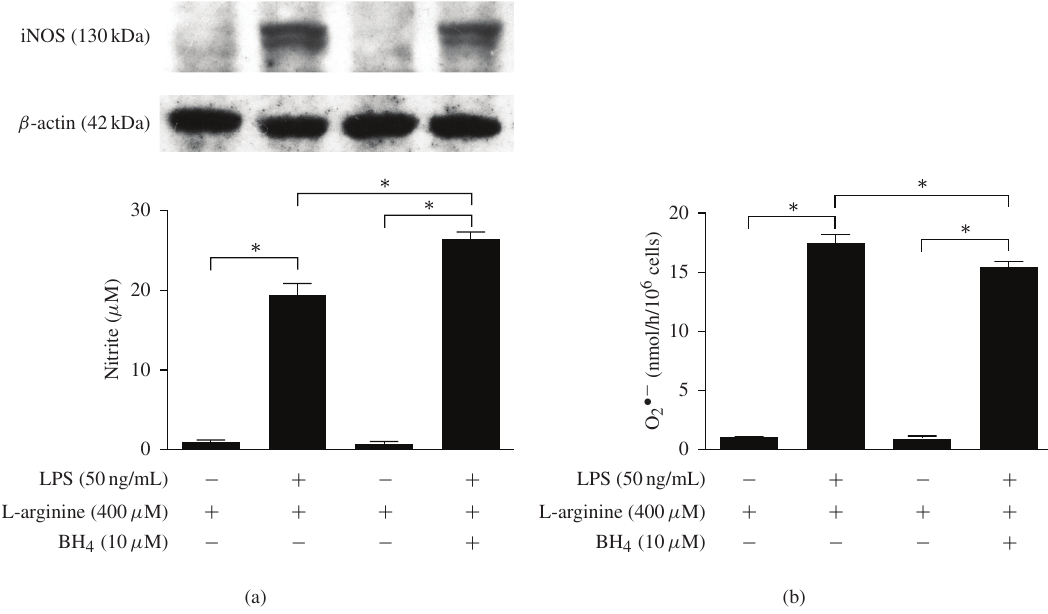
•− production in RAW